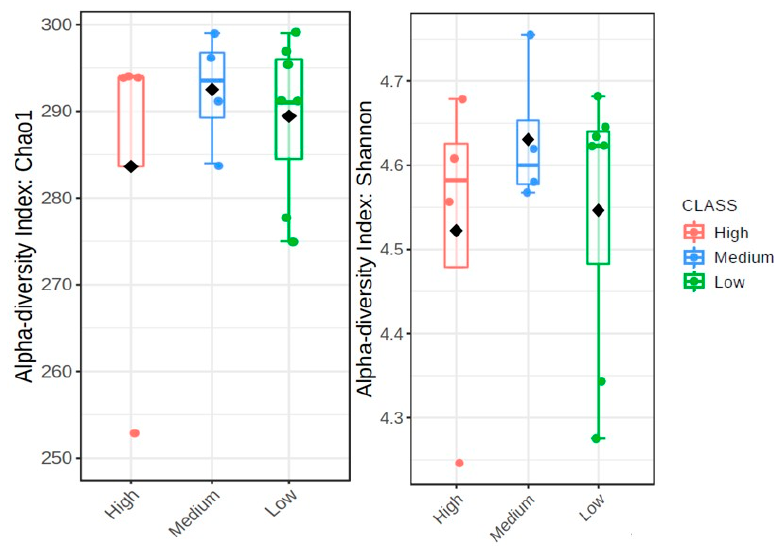
Figure 4. The alpha diversities with regards to Pratylenchus infection in soybean roots from the Highveld production area (Mpumalanga province) in South Africa presented as boxplots. The data was plotted with the Chao1 ( p = 0.614) and Shannon ( p = 0.592) diversity indices with p < 0.05; the median as well as highest and lowest values are indicated on each boxplot.